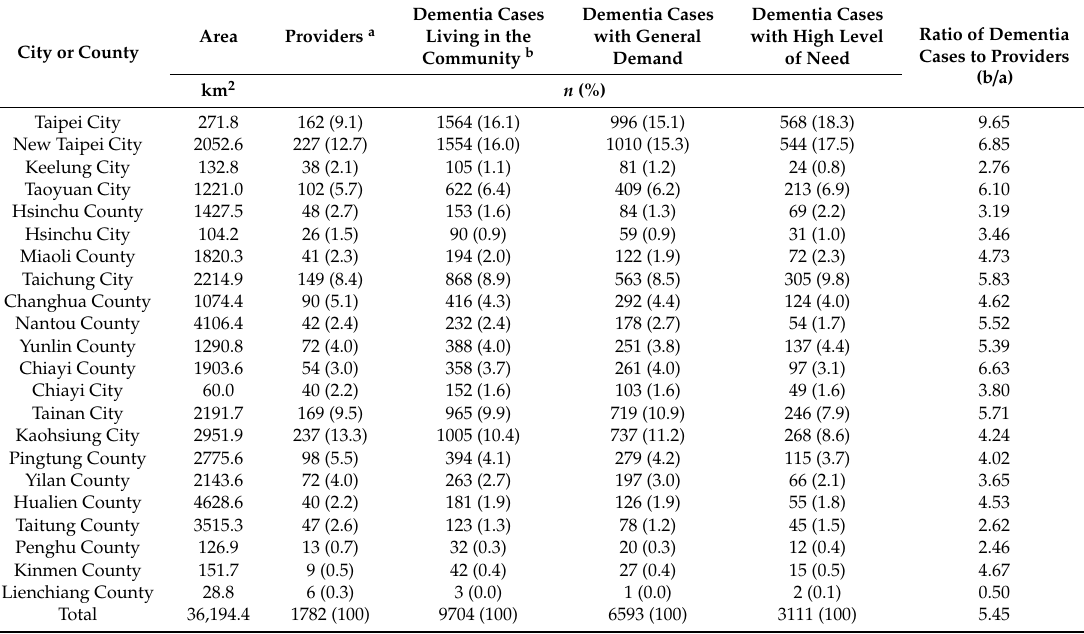
Table 3. Profiles of providers and dementia cases in 22 administrative areas in